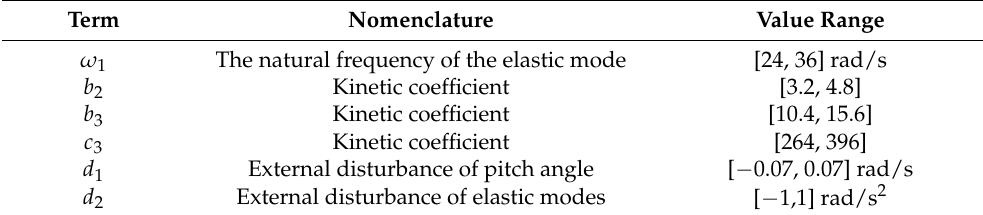
Table 1. Parameter variation range